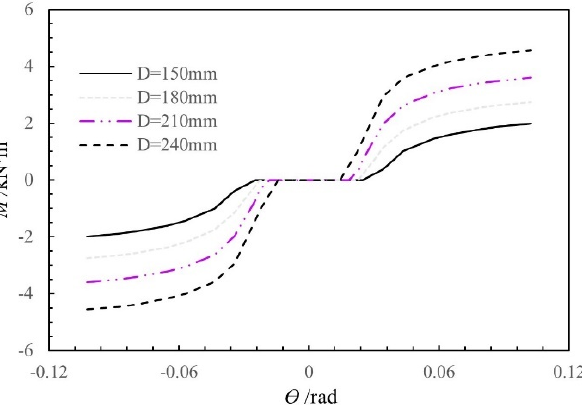
Figure 18. Moment-rotation curves of SMTJ/WP for different diameters of the column.